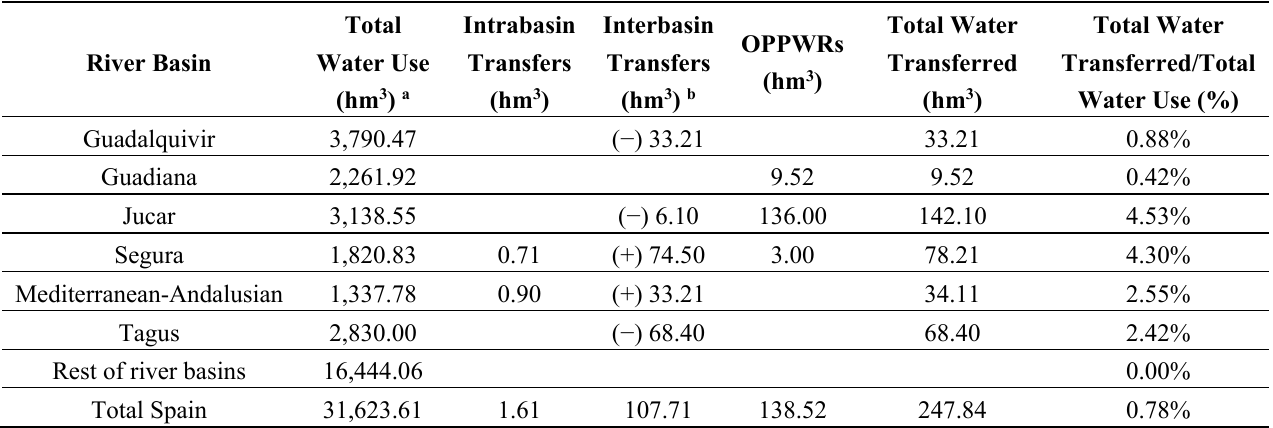
Table 2. Volume of water used and transferred through water markets per river basin. Year